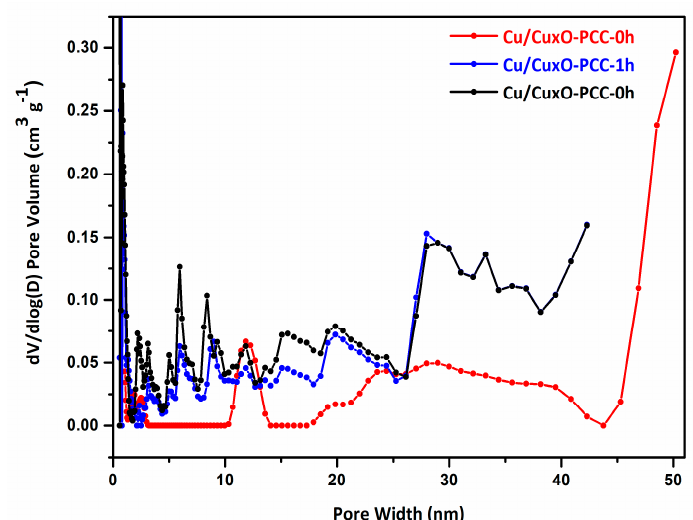
Figure 6. DFT pore size distribution for the three catalysts.